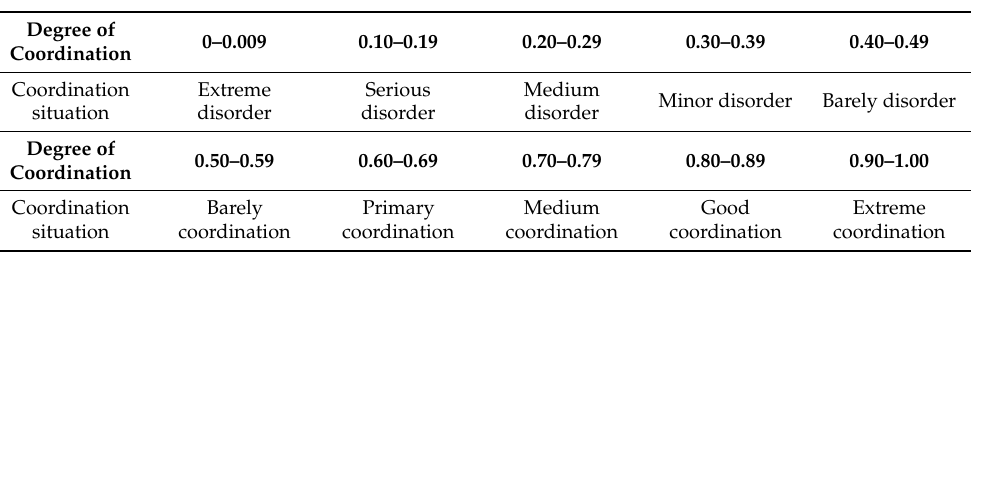
Table 4. Evaluation criteria of coupling coordination